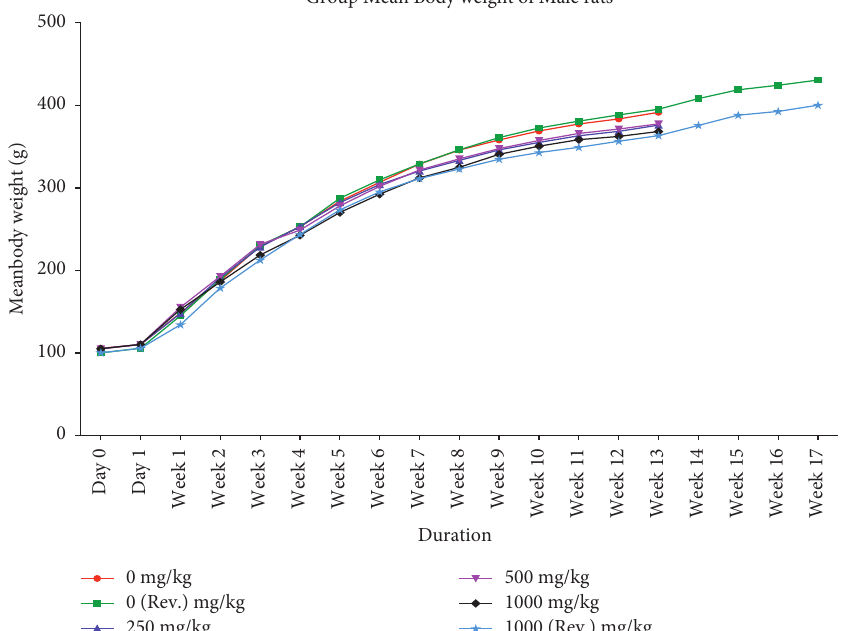
Figure 1: Group mean body weight (mean ± SD) of male rats orally administered with GutGard for 90 days ( n � 10; n � 5 for reversal groups; p ≤ 0 .